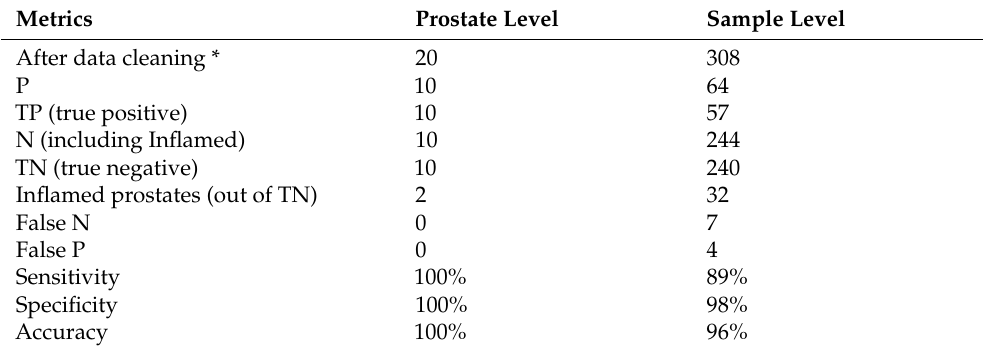
Table 2. Analysis—Biopsy Quality